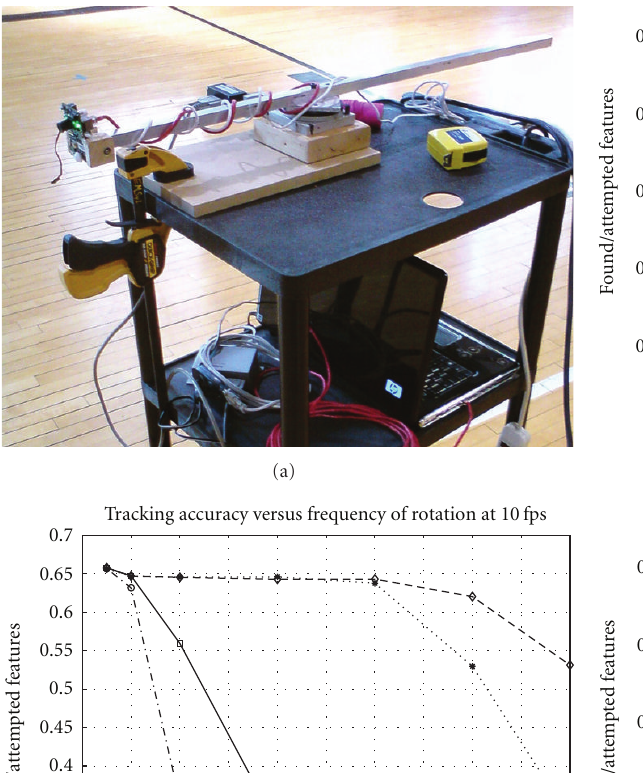
the data from each. The estimate of the orientation of the IMU relative to camera may have been inaccurate as